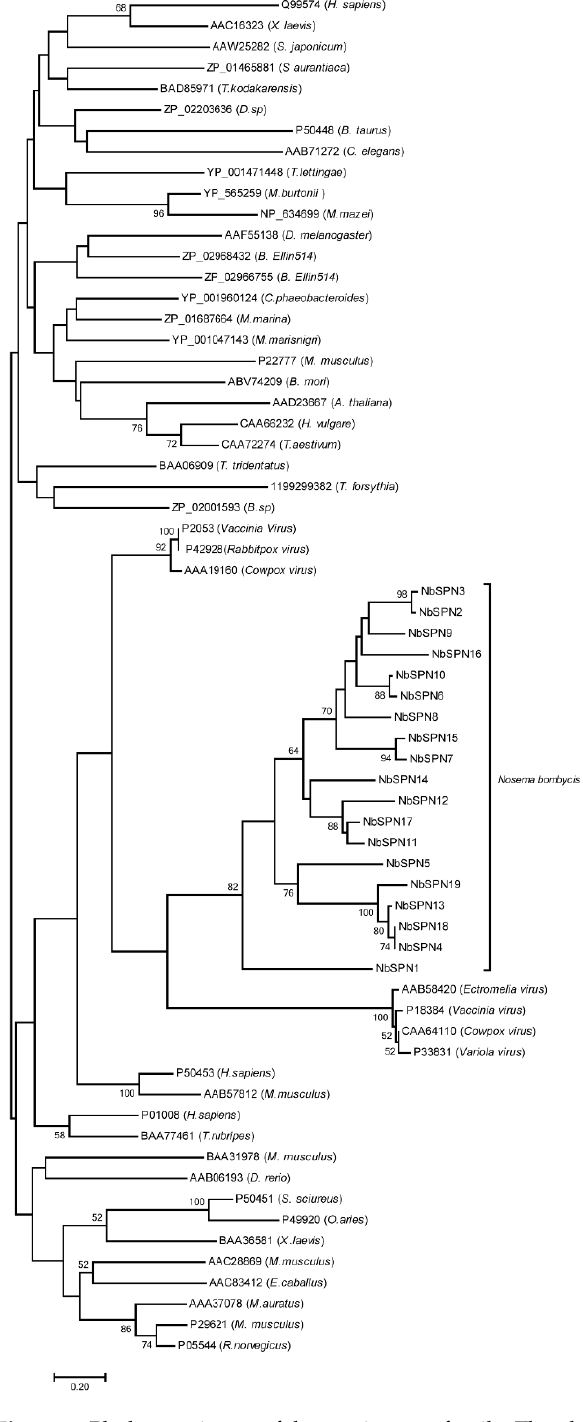
Figure 7. Phylogenetic tree of the serpin superfamily. The phylogenetic analysis of the serpins from N. bombycis , plants, animals, and viruses, etc., was from the NCBI GenBank database. The classification reference was from James A. Irving [34]. The end of each branch represents the GenBank accession number, and the name of the species is in parentheses. The phylogenetic analysis was performed using the MEGA-X neighbor-joining method. The analysis was performed on 1000 bootstrapped datasets.